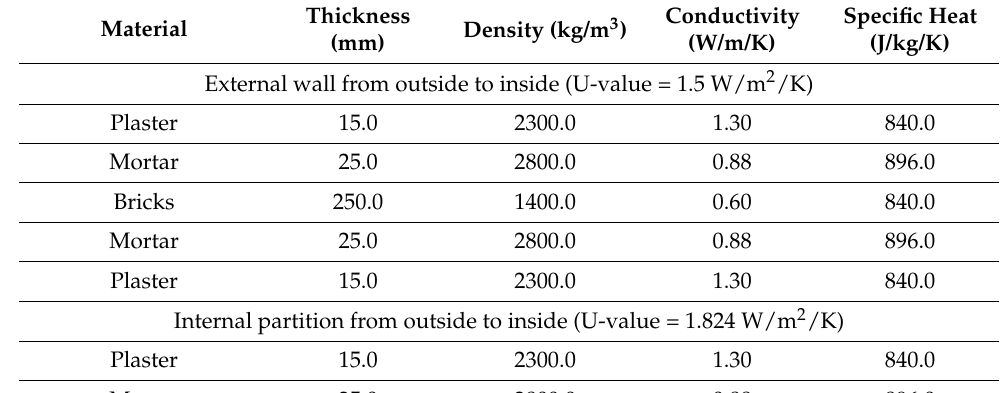
Figure 3. Typical floor plan of the building. Table 1. Thermal properties of the opaque part of the